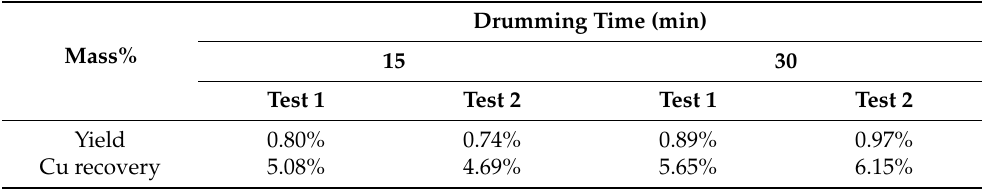
Table 3. Drumming tests results in terms of yield and recovery of copper tangles.